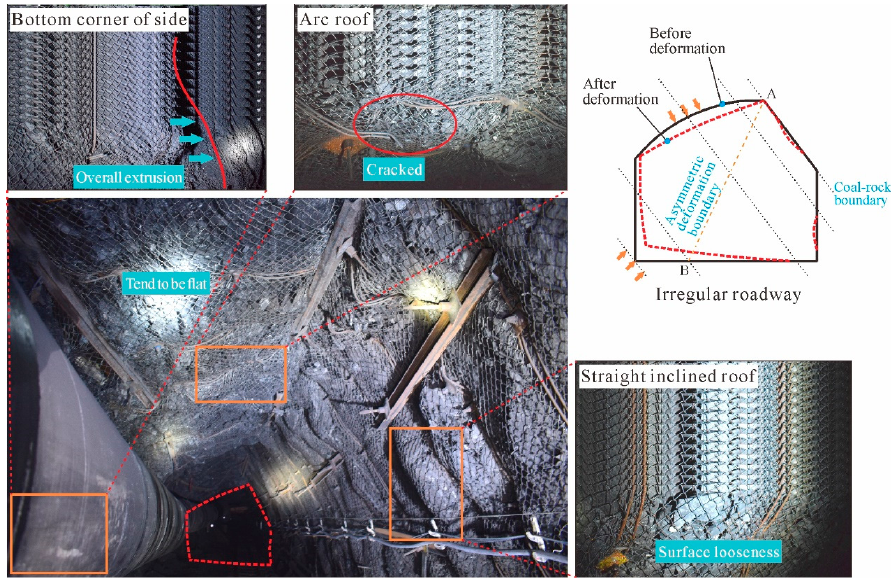
Figure 3. Failure status of the roadway under the primary